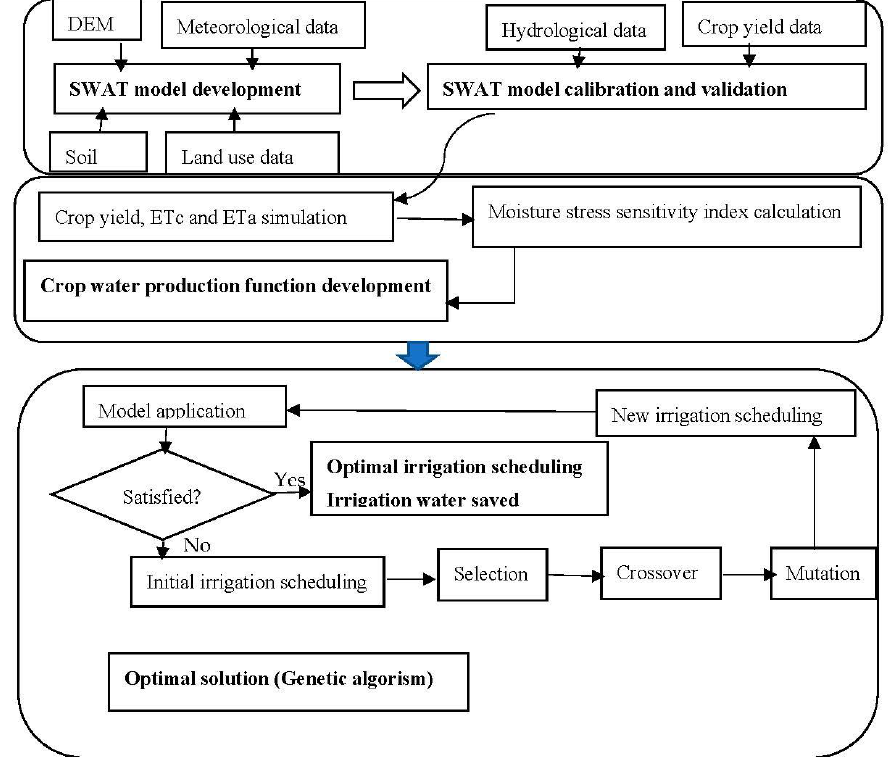
Figure 3. Diagrammatic representation of the study .